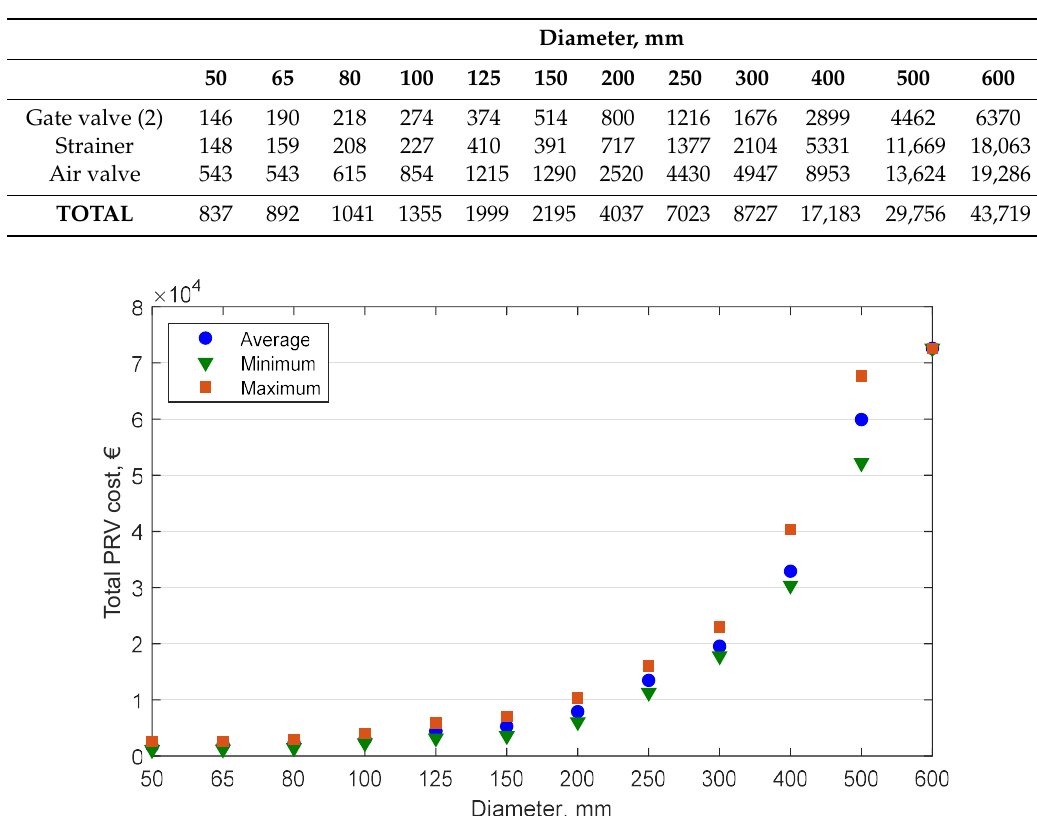
Figure 6. PRV cost for diameters ranging from 50 mm to 600 mm. Table 1. Additional costs related to the PRV installation.